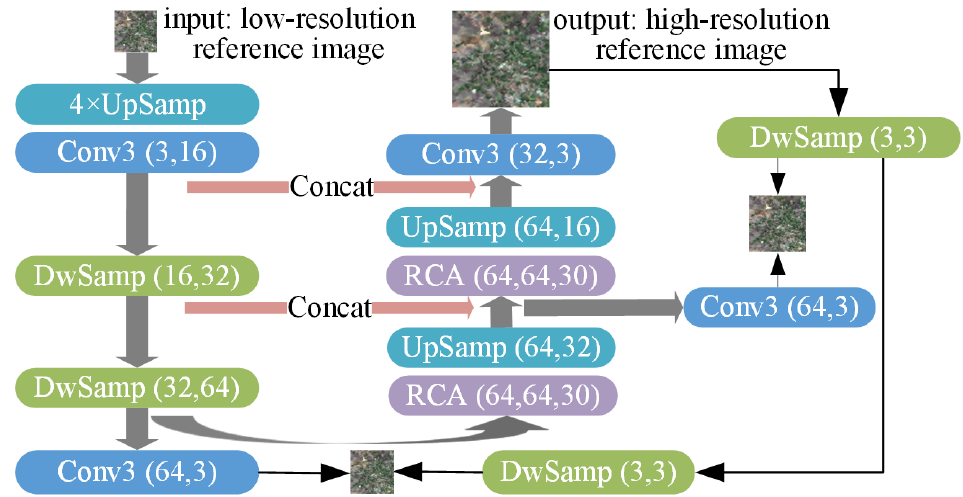
Figure 5. Structure of dual regression networks (DRN).